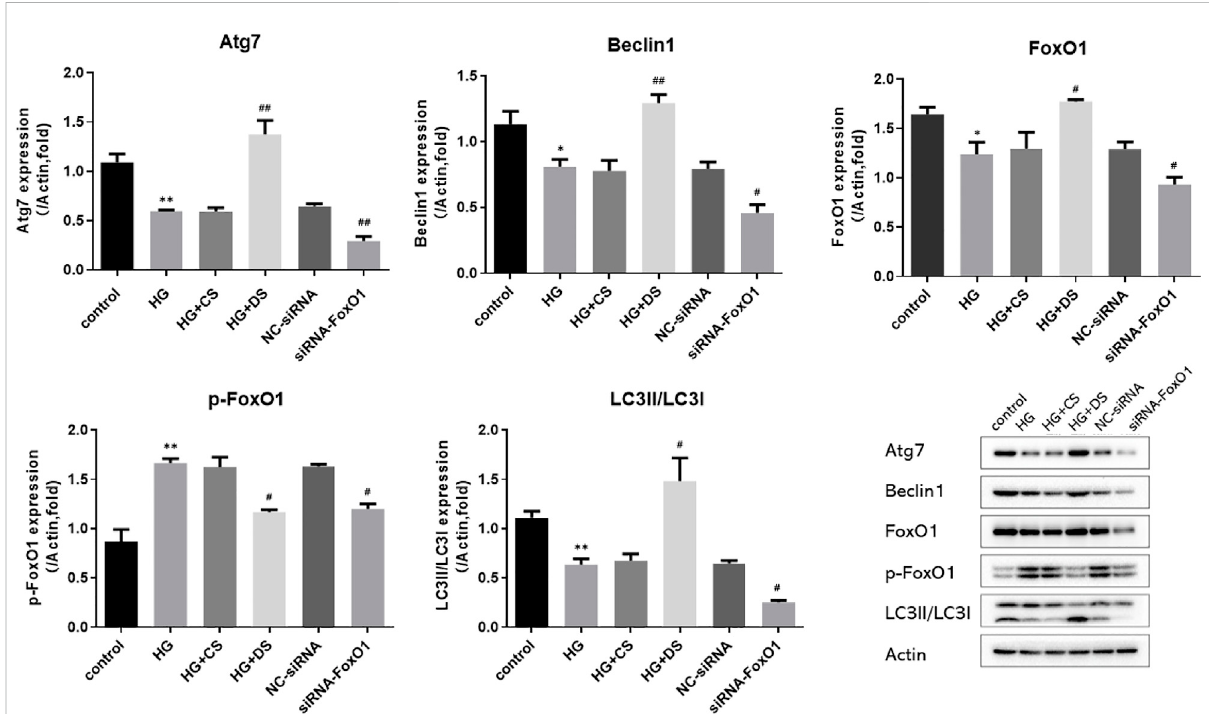
FIGURE 14 WesternblotanalysisofAtg7,FoxO1,p-FoxO1,Beclin1,LC3andActinproteinexpressioninH9c2cells.* p < 0.05vs.controlgroup,** p <